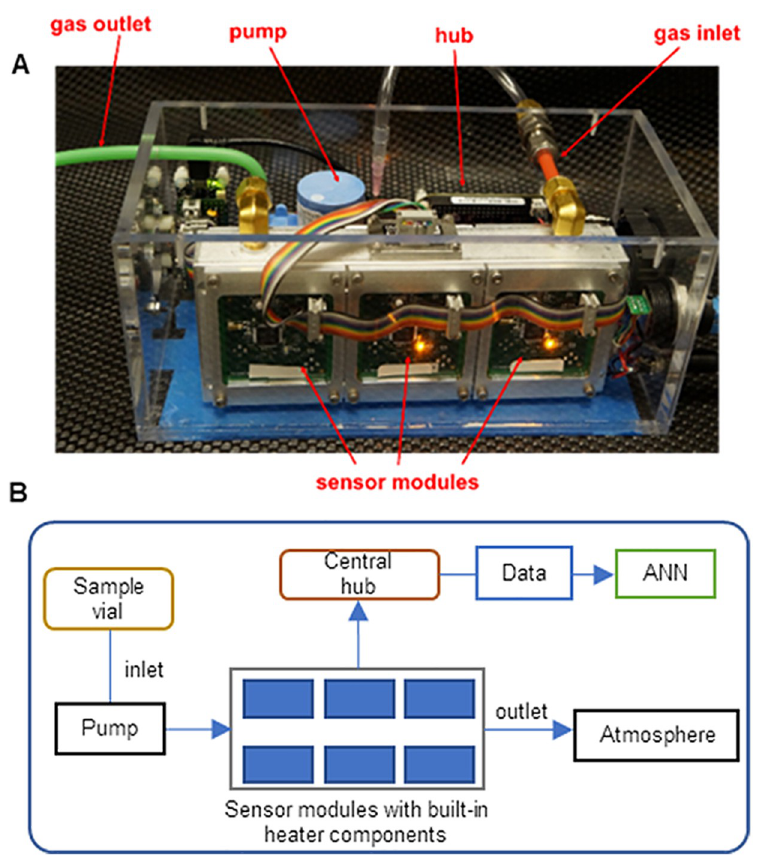
Fig 1. The Electronic Volatile Analyzer (EVA). (A) Sensor array prototype with parts labeled. (B) A block diagram of key components of the EVA.